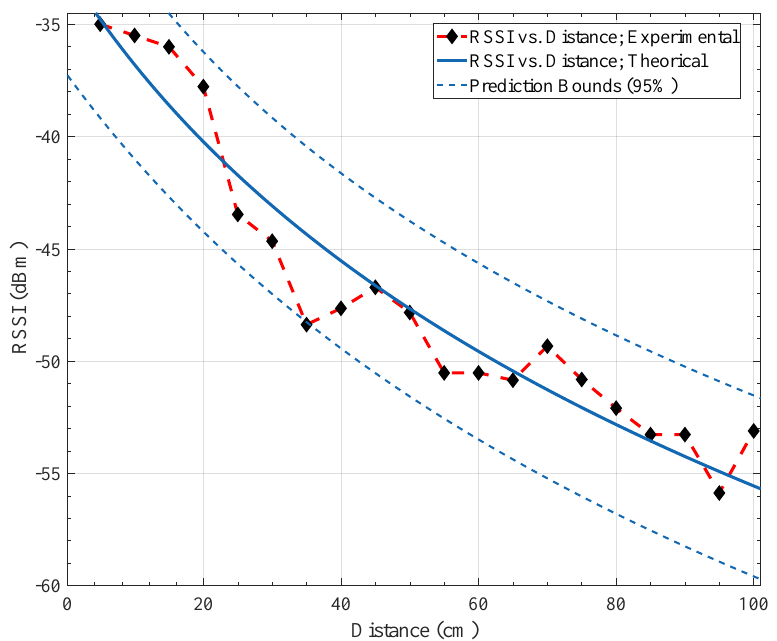
Figure 5. Experimental and theoretical distance dependence of the path loss characterization with n = 1.8, σ = 1.88, and X σ = 53.28.